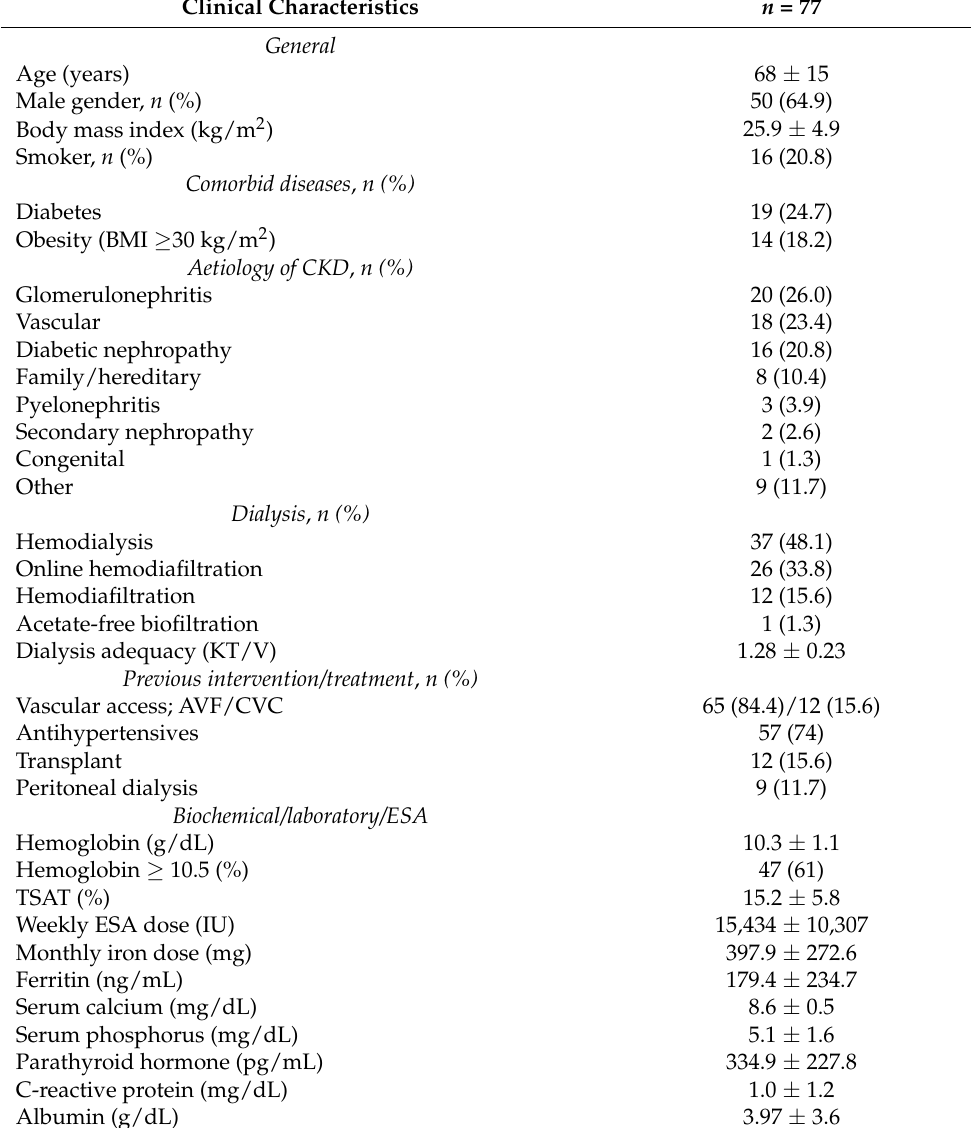
Table 1. Baseline clinical characteristics of patients on